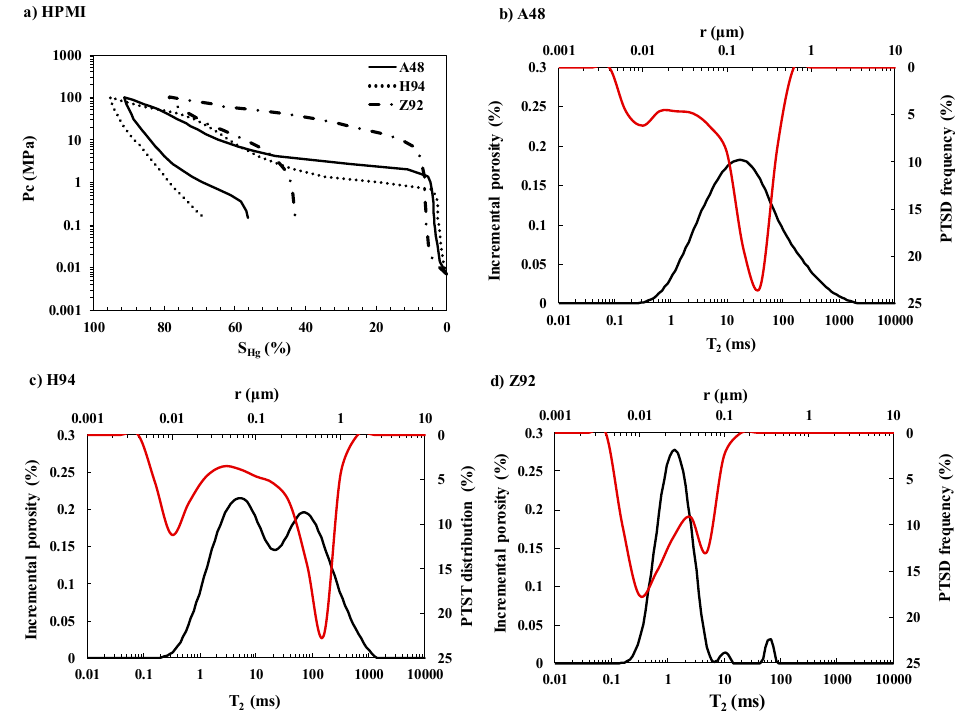
Figure 4. Comparison between pore throat size distribution (PTSD) derived from high-pressure mercury intrusion (HPMI) tests and NMR T 2 spectra: ( a ) Mercury intrusion capillary pressure of three core plugs; ( b ) PTSD derived from HPMI test and NMR T 2 spectra for the core plug A48; ( c ) PTSD derived from HPMI test and NMR T 2 spectra for the core plug H94; ( d ) PTSD derived from HPMI test and NMR T 2 spectra for the core plug Z92.